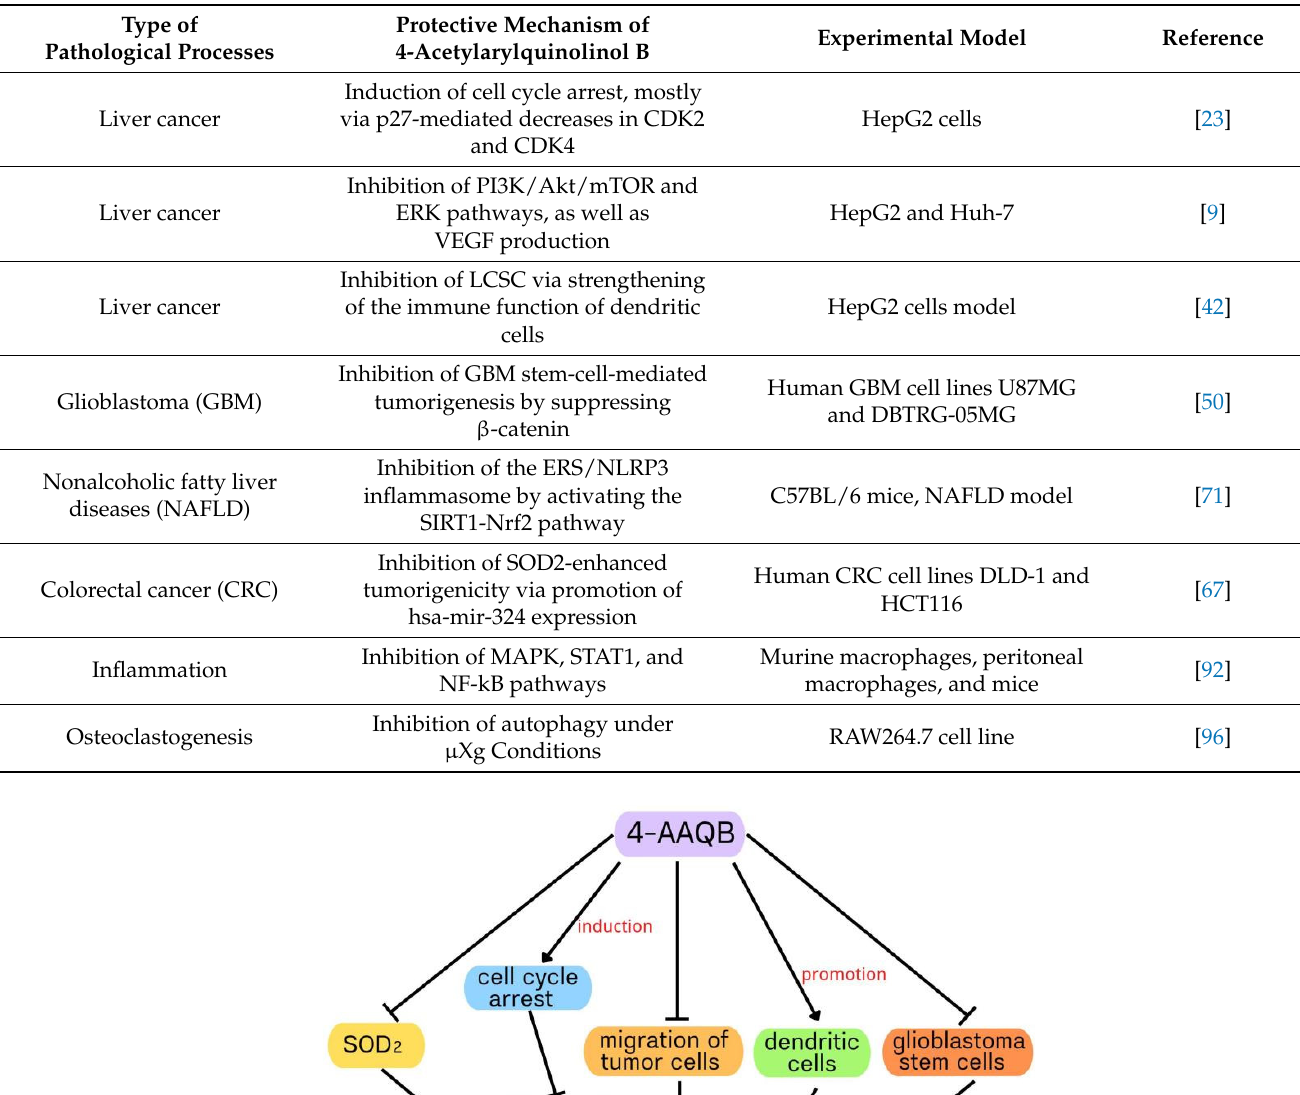
Table 1. Summary of protective roles of 4-acetylarylquinolinol B in pathological processes.